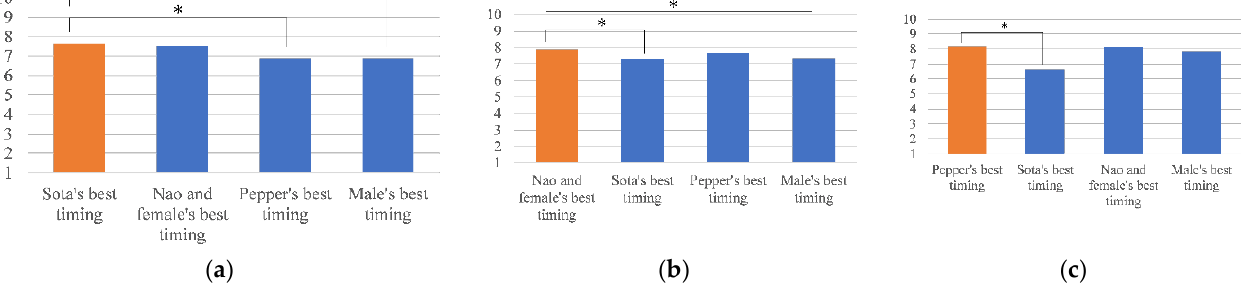
Figure 7. Comparison with other best combination timing for Sota, Nao and Pepper. ( a ) naturalness of Sota, ( b ) naturalness of Nao, ( c ) naturalness of Pepper. * p < 0.1.